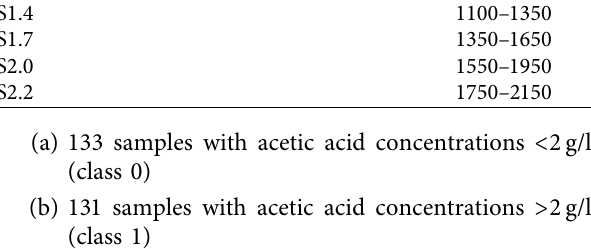
Table 1: Sensor types and wavelength ranges. NIR sensor